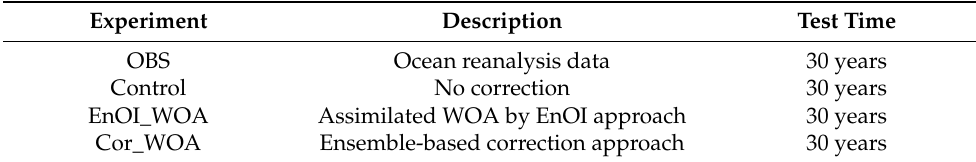
Table 2. Configuration of experiments using the correction scheme.